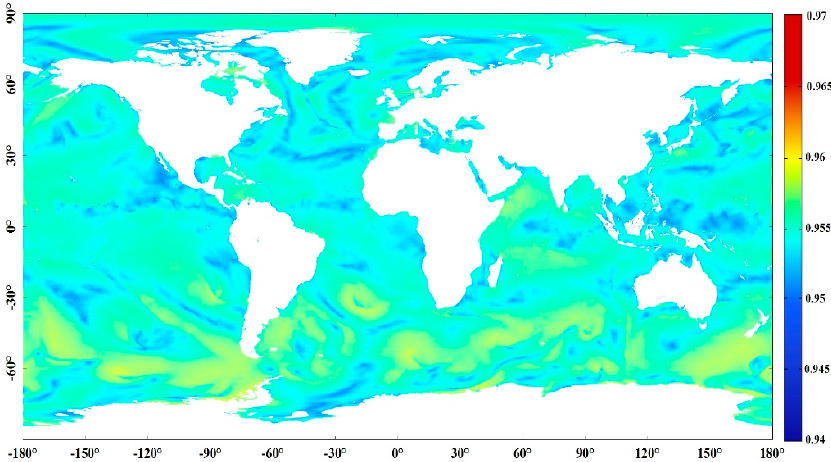
Figure 10. Map of global sea surface hemispherical BBE values at 12:30 (UTC time) on 1 July 2003.